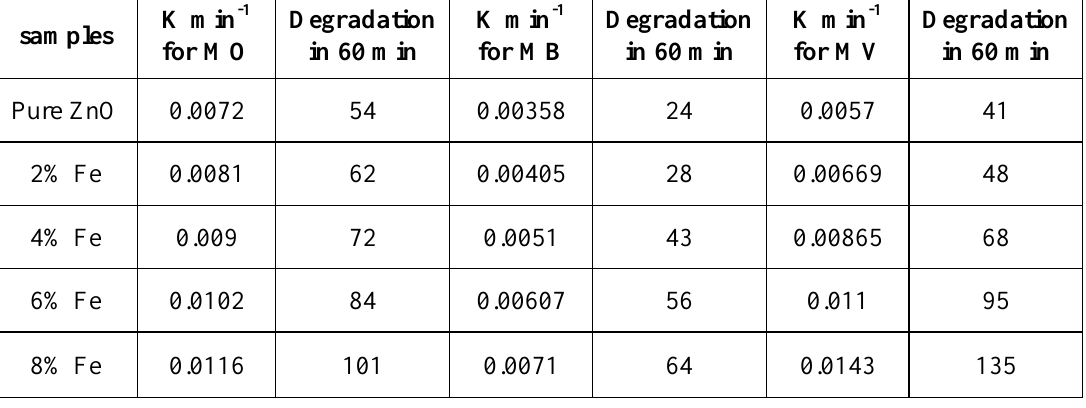
Table 2: Illustrate the rate constant (k) and degradation (%) of the (a) MO, (b) MB and (c) MV (100 mg/l)